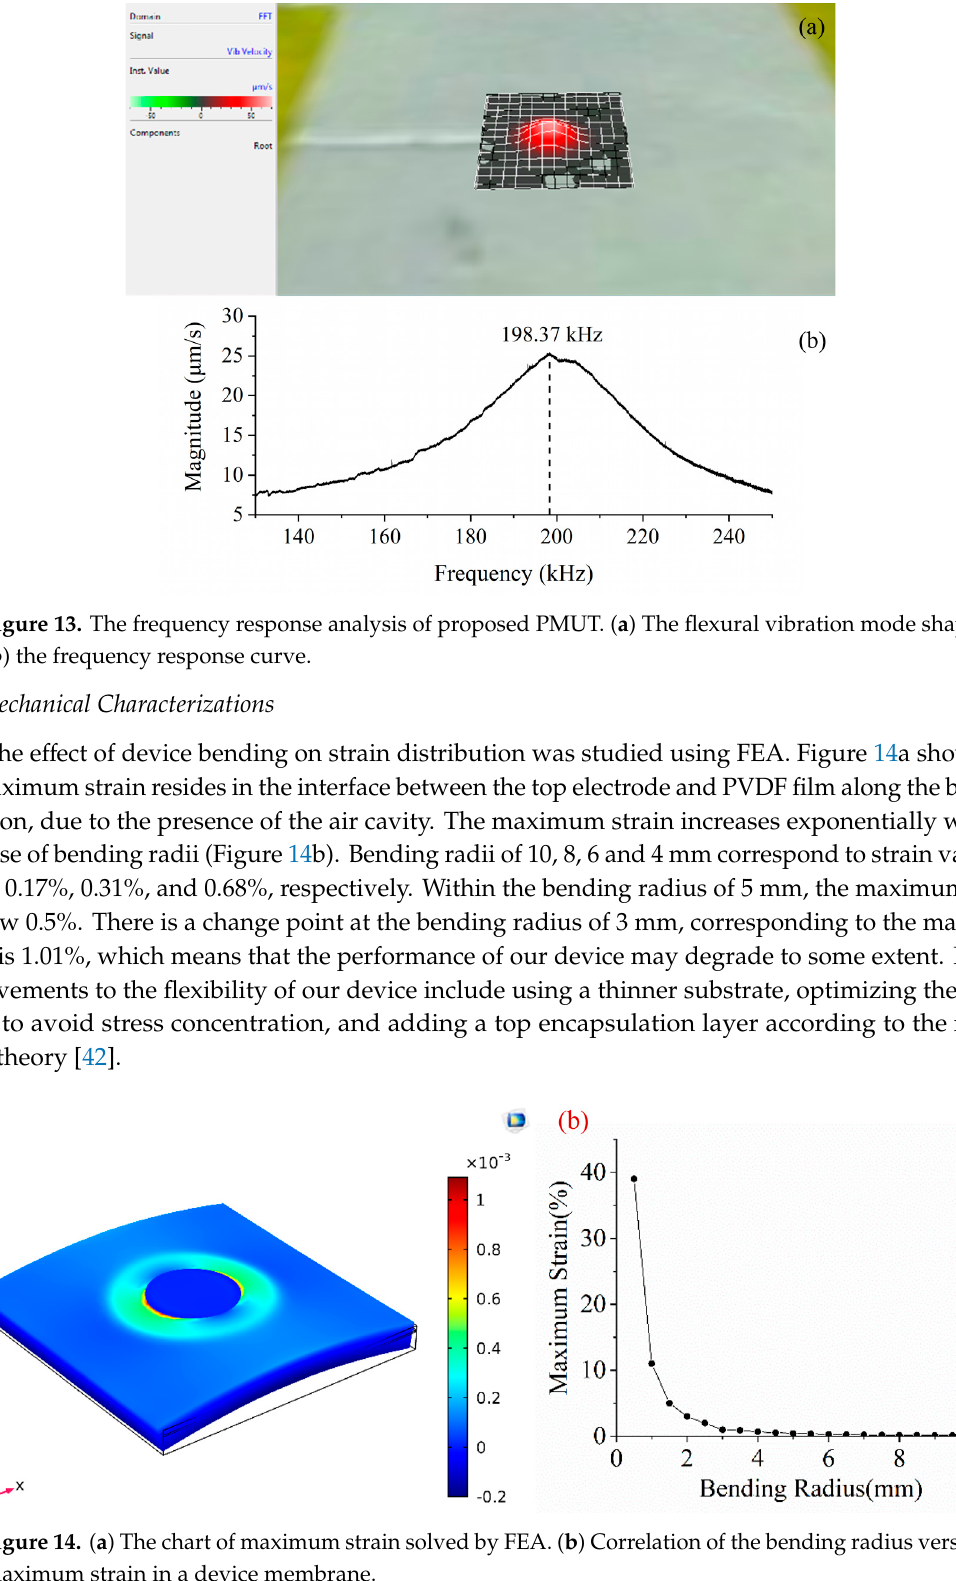
Figure 12. The optical image of PMUT mounted on a glass sheet.